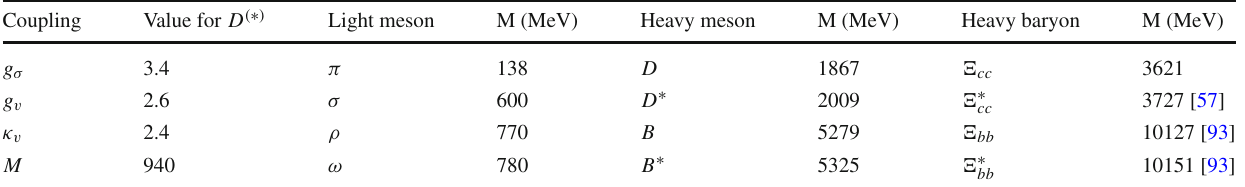
virtual state. The c and b subscripts denote the charm and bottom sector, respectively. The uncertainties originate from the HQSS breaking of